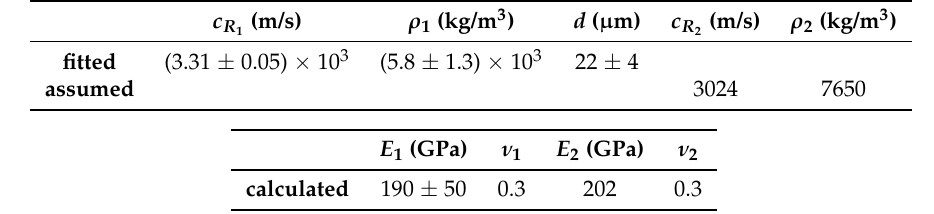
Table 2. Obtained best fitted parameters for the GESA modified coating and their least-squared uncertainties together with the assumed T91 steel substrate’s properties (top table). From these fitted parameters, Young’s moduli of the coating and substrate materials were calculated (bottom